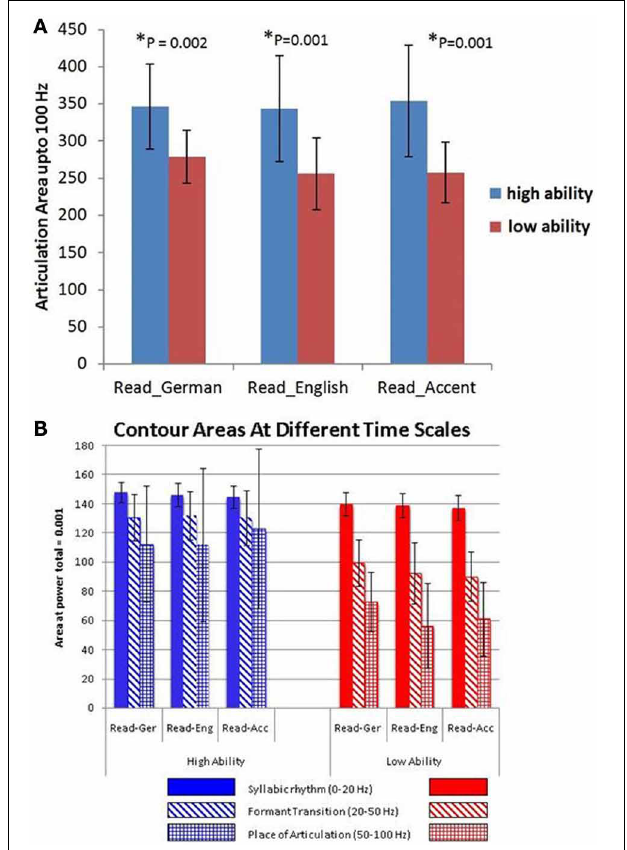
FIGURE 4 | (A) Articulation space in numbers (area plots covering the articulation areas based on the modulation spectrum analysis) for both non-native ability groups, the German-speaking low-ability (red bars) and high-ability (blue bars) speech imitators. Bar graphs are given for the three in-scanner behavioural task conditions: Read_German, Read_English sentences and “Read_Accent” ( = faking a foreign accent in mother tongue sentences, here, an English accent in German sentences). The lower panel (B) shows the group differences of different articulation area spaces (contour areas) in more detail according to the three different articulation time/frequency scales: blue bars - SR = syllabic rhythm, 0–20Hz; red bars - FT = formant transition, 25–40Hz; green bars - POA = place of articulation,